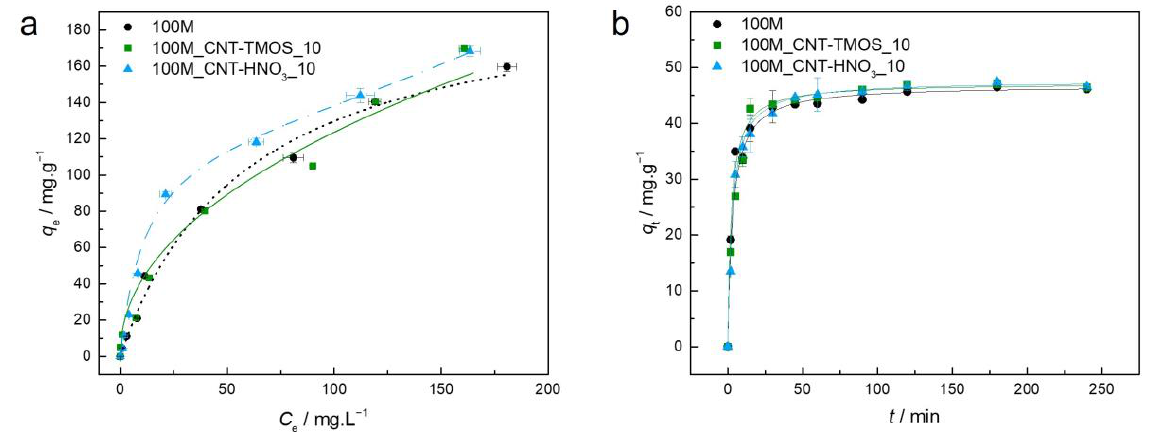
Figure 3. ( a ) — Experimental equilibrium data and the best fitted isotherm model for adsorption of toluene into the studied aerogels (dotted line — Langmuir; solid line — Freundlich; dashed line — BET). ( b ) — Representative plots of the fit of non-linearized form of pseudo-second order equation (solid line) to the data of experimental adsorption capacity as function of time, for the studied adsorbents towards toluene ( C 0 = 100 ppm, 15 rpm, 20 °C).